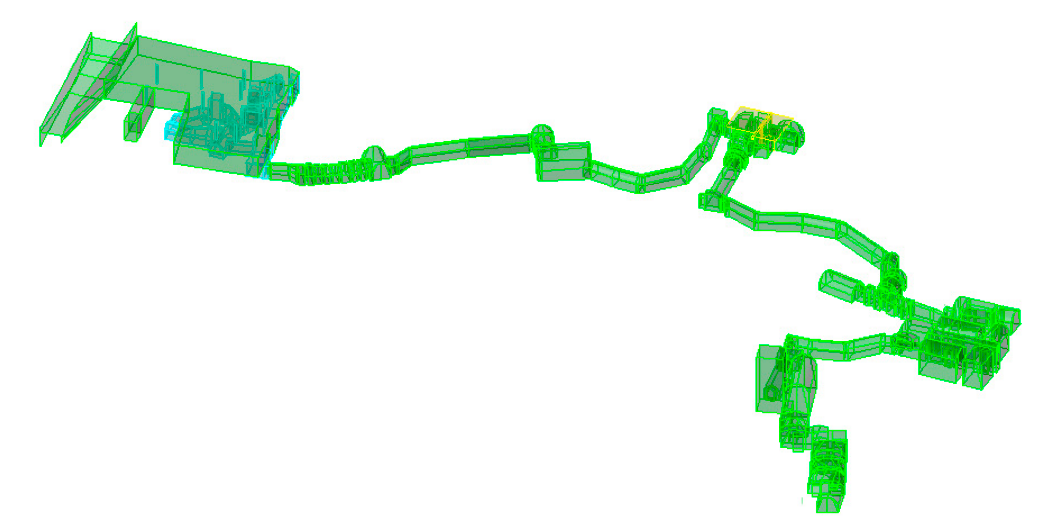
Figure 20. Three-dimensional model of the Underground Tourist Route.